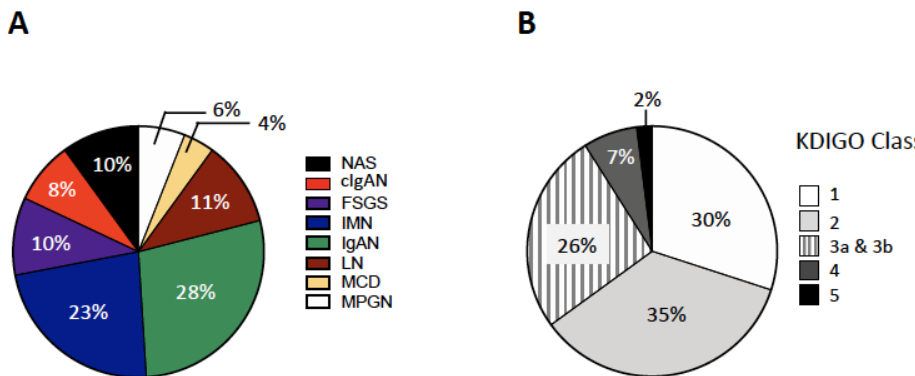
Figure 1. Distribution of nephropathies at histological analysis in the overall cohort (Panel A ) and distribution of patients by Kidney Disease Improving Global outcomes (KDIGO) classification in the overall cohort (Panel B ). IgAN: IgA nephropathy; IMN: idiopathic membranous nephropathy; LN: lupus nephritis; FSGS: focal segmental glomerulosclerosis; cIgAN:screscentic IgA nephropathy; MPGN: membranoproliferative glomerulonephritis; MCD: minimal change disease; NAS: nephroangiosclerosis.